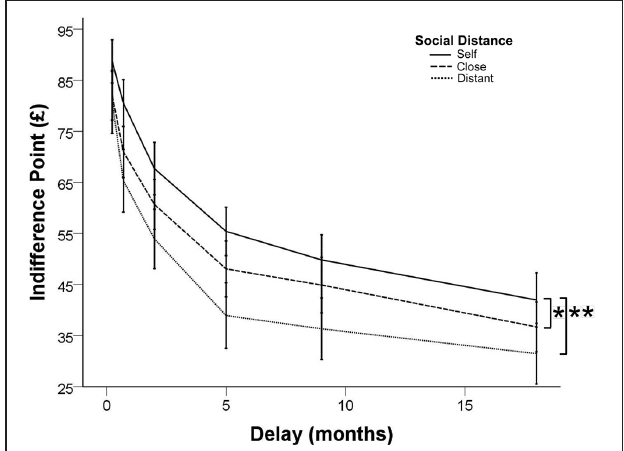
FIGURE 3 | Temporal discounting curves for social conditions. Error-bars at 95% CI and adjusted for within-subjects variance (significantly different at: ∗ 0 . 05 level; ∗∗ 0 . 01